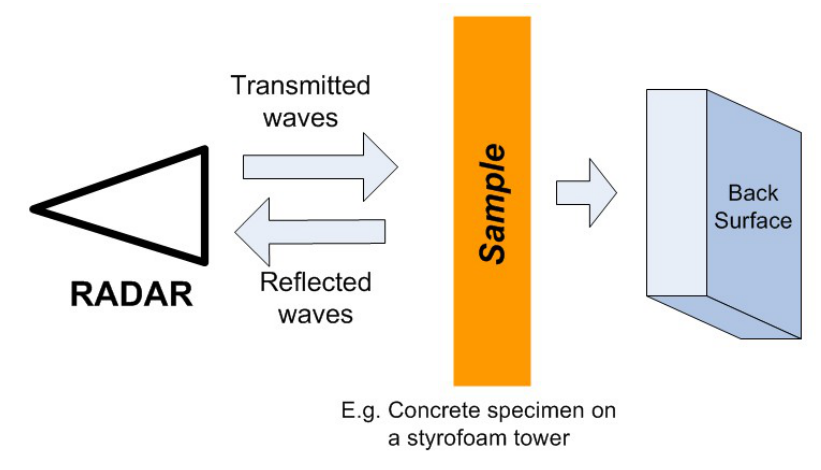
Figure 30. A typical radar imaging setup.